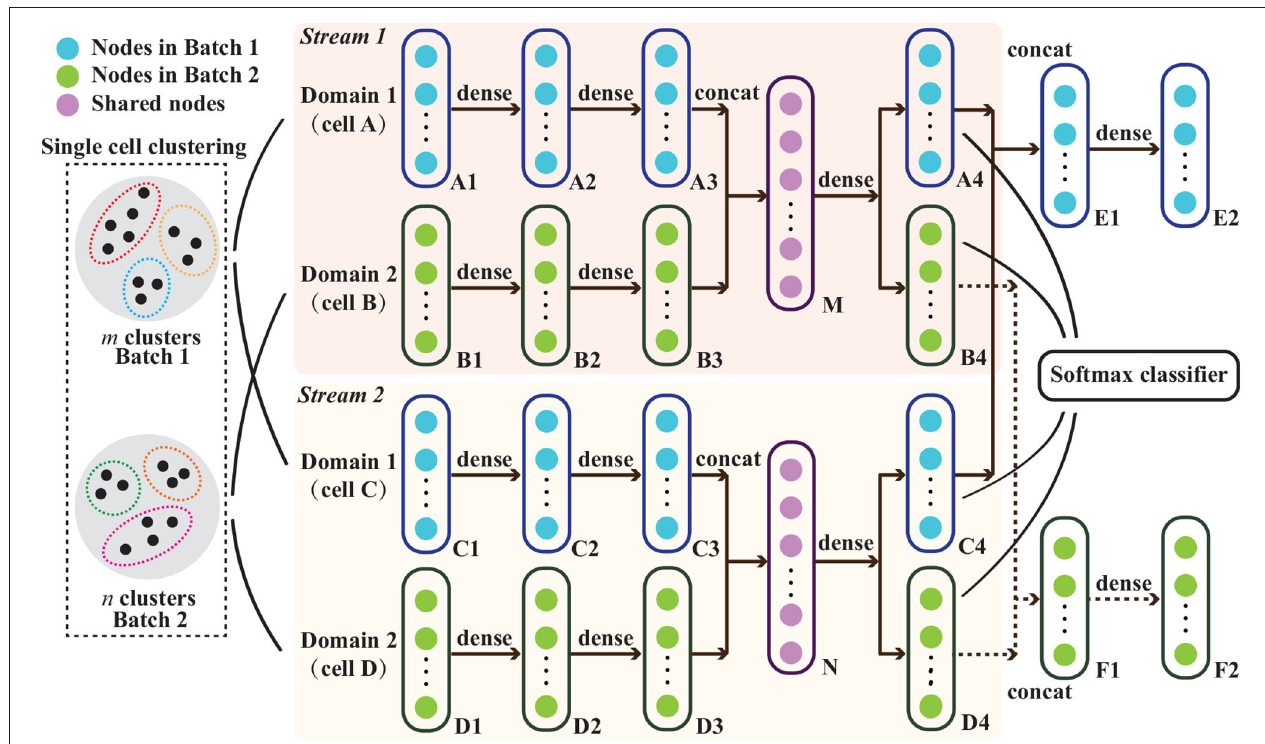
FIGURE 1 | Schematic representation of the proposed cluster-driven batch alignment (CBA) method to align single cell RNA-seq measured in two different batches. The unsupervised clustering for cells from both batches and the network architecture in CBA are shown and the explanation of various nodes are listed on the top left corner. Cell A and cell C are from batch one, and cells B and D are from batch two. At its core, the alignment is done using an autoencoder where cells A&B are aligned and embedded in a lower dimensional representation M and, simultaneously, cells C&D are aligned and embedded in N. M&N are subsequently used to represent the aligned cells, e.g., to make a UMAP visualization. Details on the autoencoder as well as the classification layer can be found in the section that describes CBA.